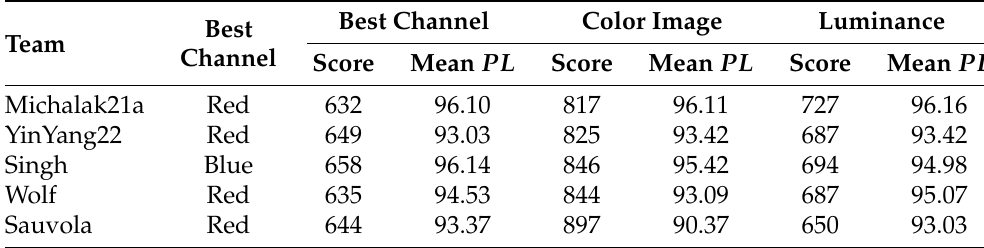
Table 3. Example of the choice of a channel with some of the best